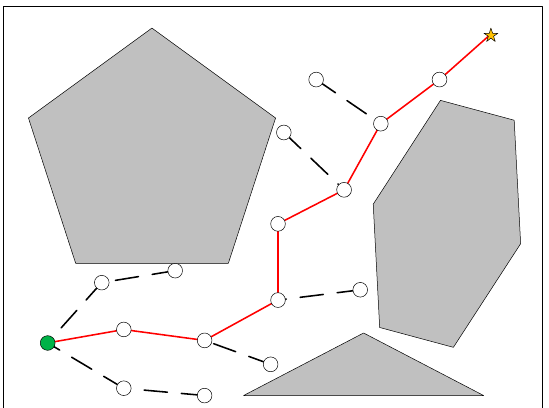
Figure 2. Illustration of the sample and extension mechanism of the RRT algorithm.